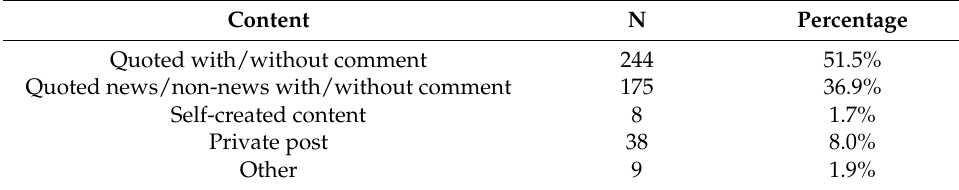
Table 2. The categories and amount of content of 474